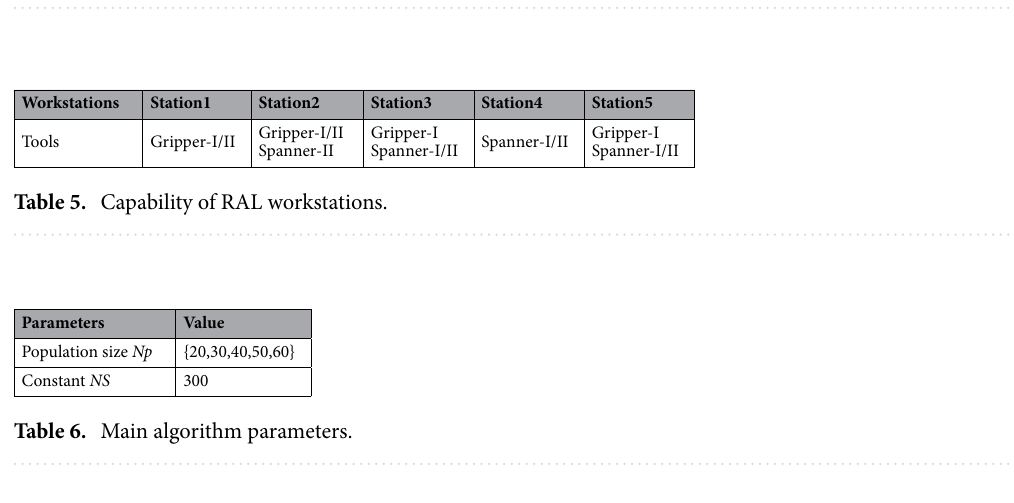
Table 4. Information of parts.